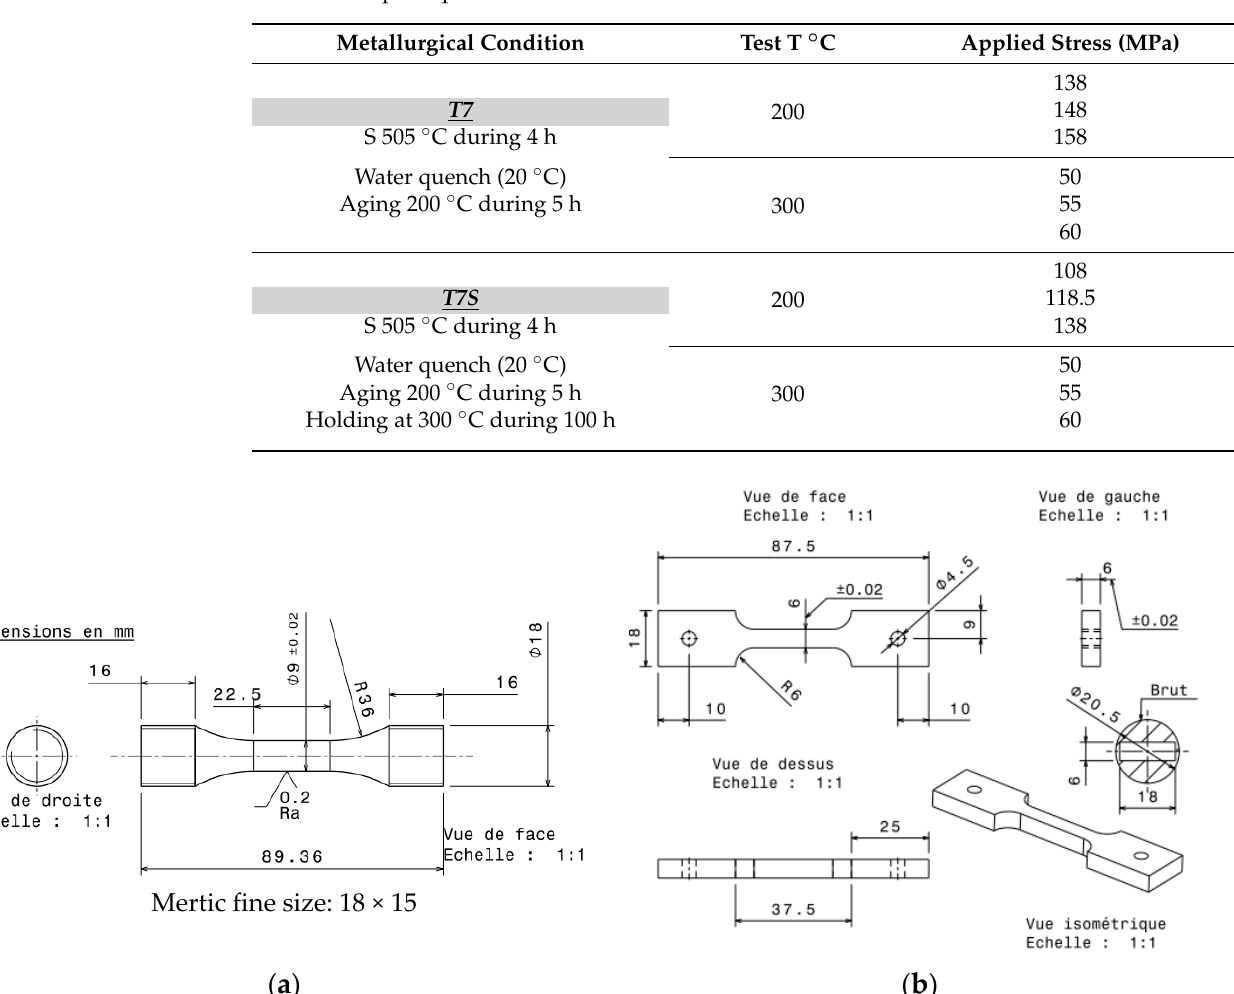
Figure 3. Technical drawing for ( a ) LCF samples and ( b ) creep samples (in